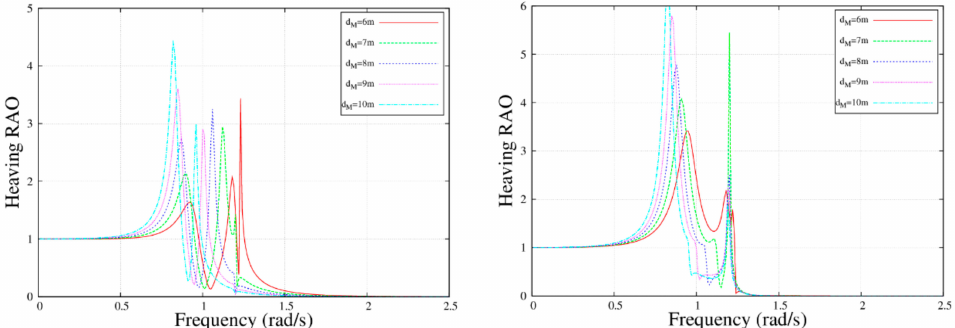
Figure 8. Response amplitude operator with the frequency for the MP and the WEB with di ff erent draft; d M = 6, 7, 8, 9, and 10 m. ( a ) X M , d M = 10 m; and ( b ) X B , d M = 10